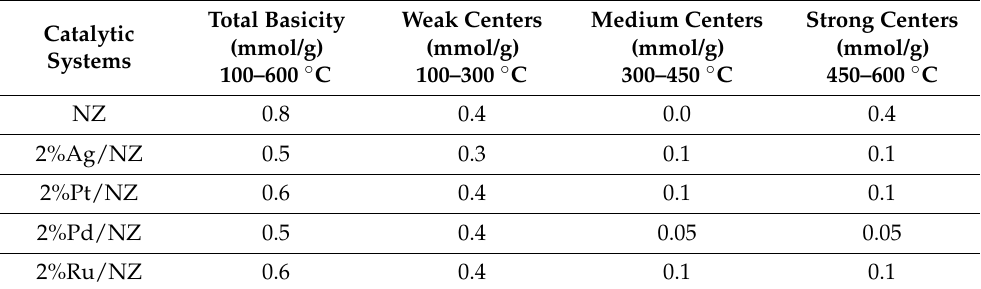
Table 6. The amount of CO 2 adsorbed on support surface (calcined in an air atmosphere for 4 h at 400 ◦ C), monometallic reduced catalysts (reduction at 300 ◦ C in a mixture of 5% H 2– 95% Ar mixture), calculated from the CO 2 -TPD